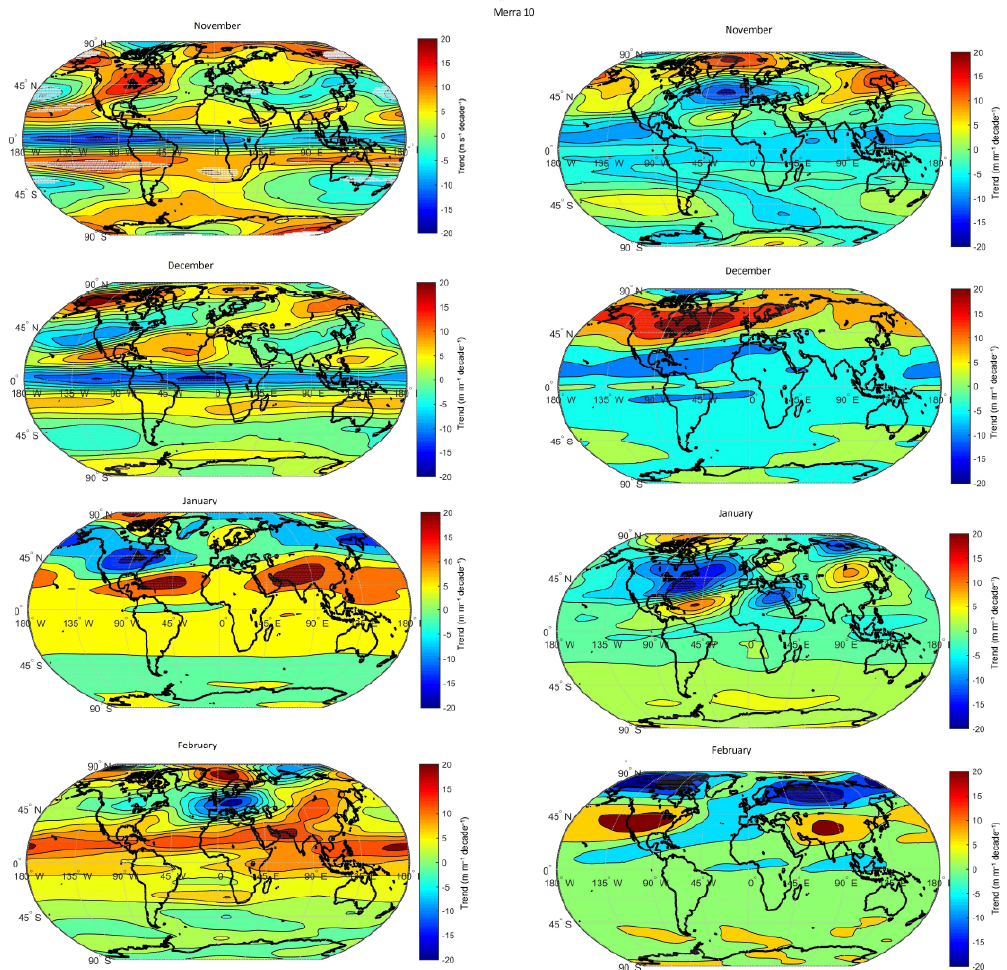
Figure 13. The same as Fig. 12 but for zonal wind